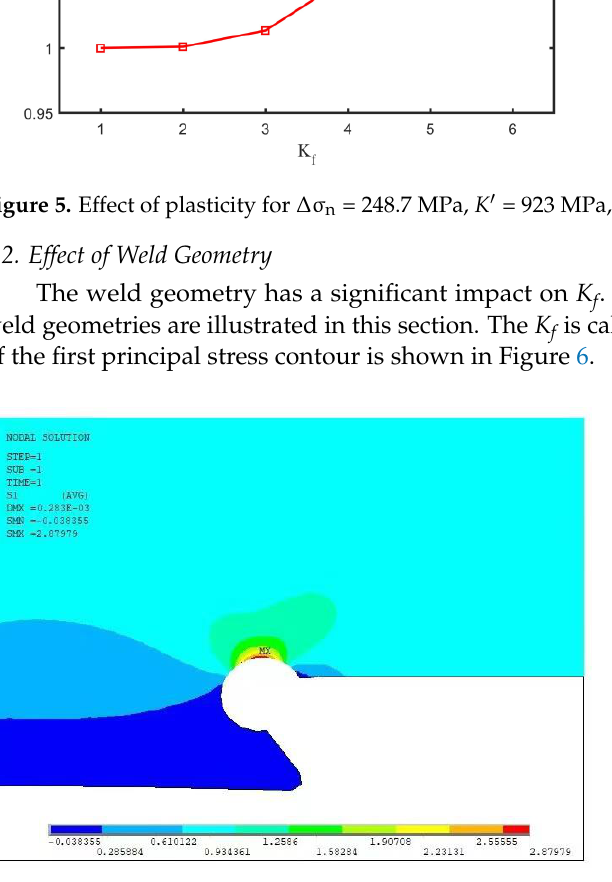
Figure 6. An example of the first principal stress contour (nominal stress is 1 MPa).